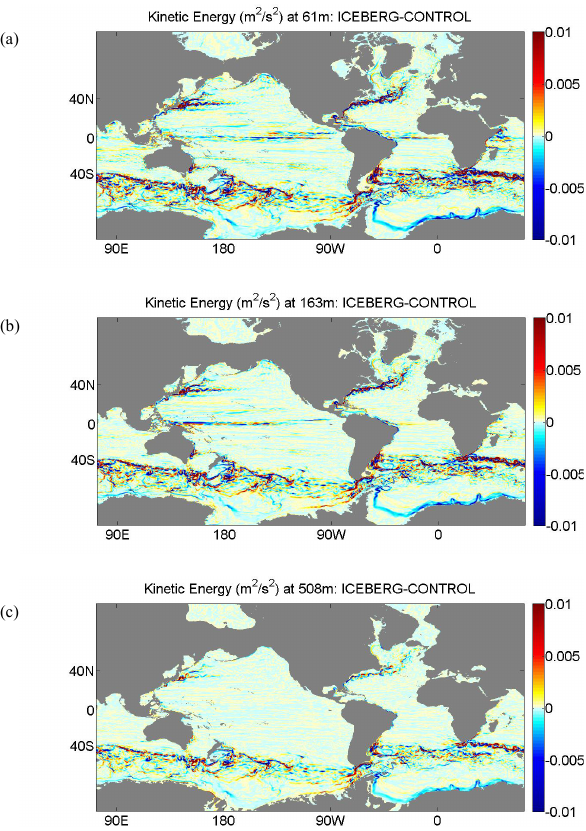
Figure 13. Differences (ICEBERG minus CONTROL) in the year 26–30 time average of kinetic energy (KE) at (a) 61m; (b) 163m; (c)